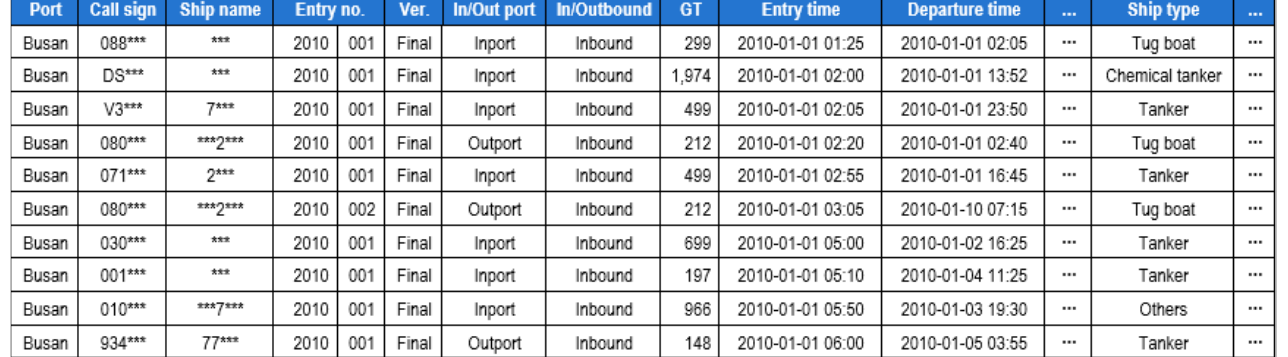
Figure 3. Port-MIS (Port Management Information System) ship entry and departure service delivery data example for Busan Port [40].